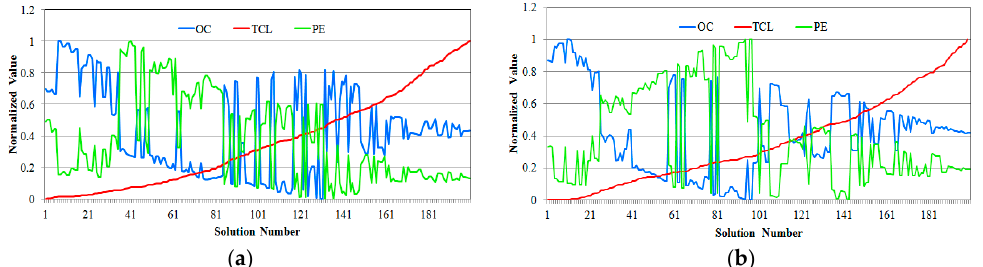
Figure 7. The normalized objectives of Pareto front of optimal scheduling for RR-microgrid with RFHCS. ( a ) A typical day in winter; and ( b ) a typical day in summer.